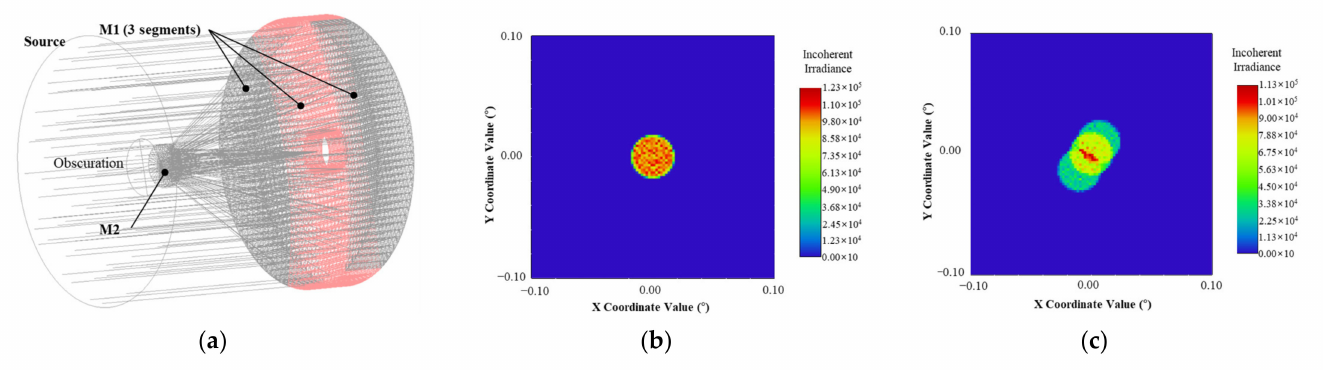
Figure 10. Payload optical system design and analysis: ( a ) optical layout and beam paths; ( b ) spot position and quality analysis by defocusing and decentering with a tip-tilt platform (FSM).